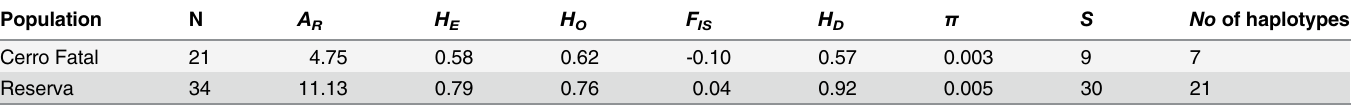
Table 1. Summary statistics from microsatellite ( N — F IS ) and mtDNA ( H D — No of Haplotypes) data for the Cerro Fatal and Reserva populations of giant tortoises on Santa Cruz